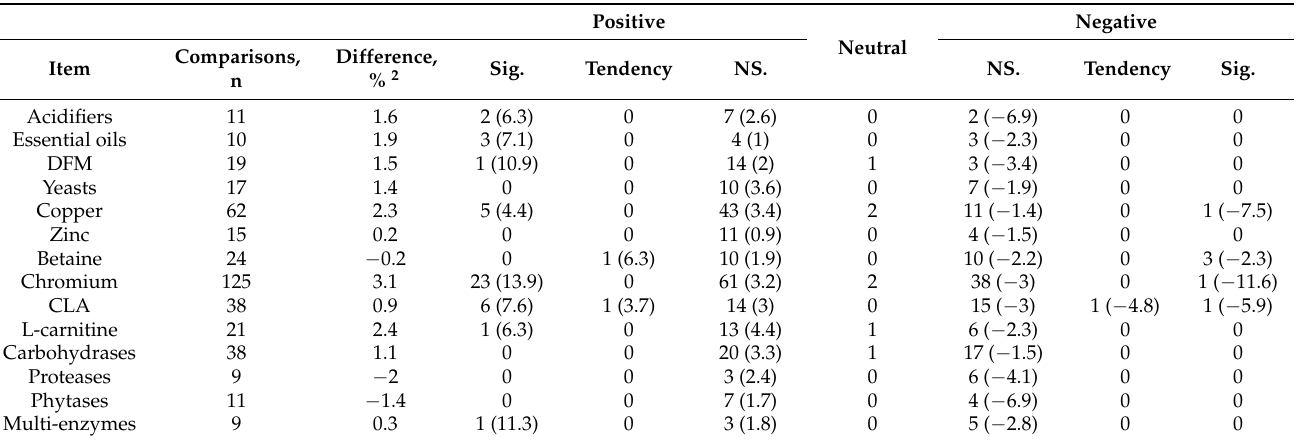
Table 5. Summary of the effects of feed additives on grow–finish pig longissimus muscle area/loin depth 1,3